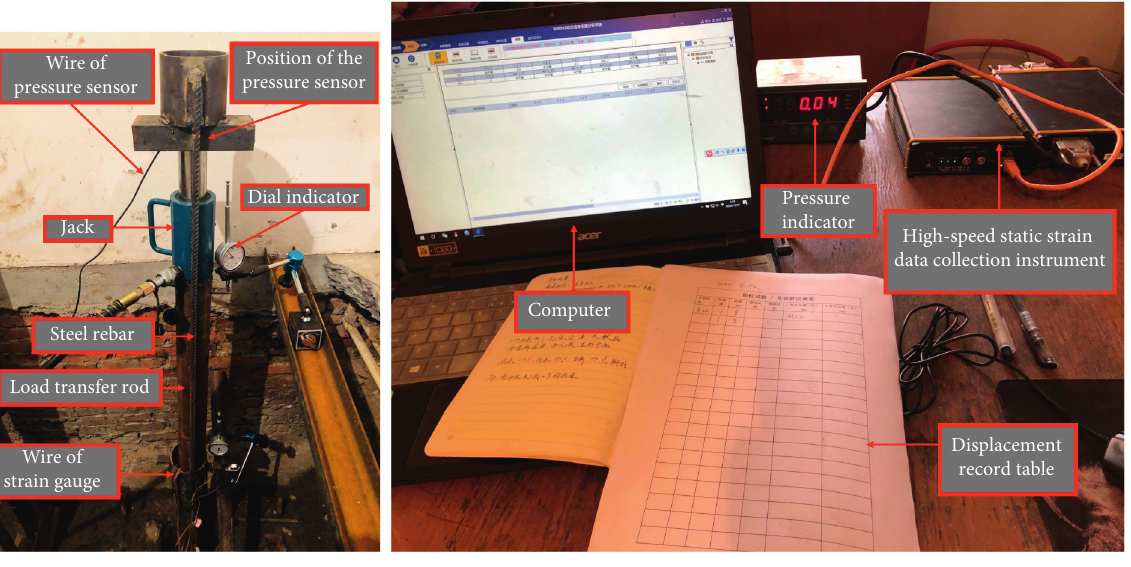
Figure 4: In situ test.